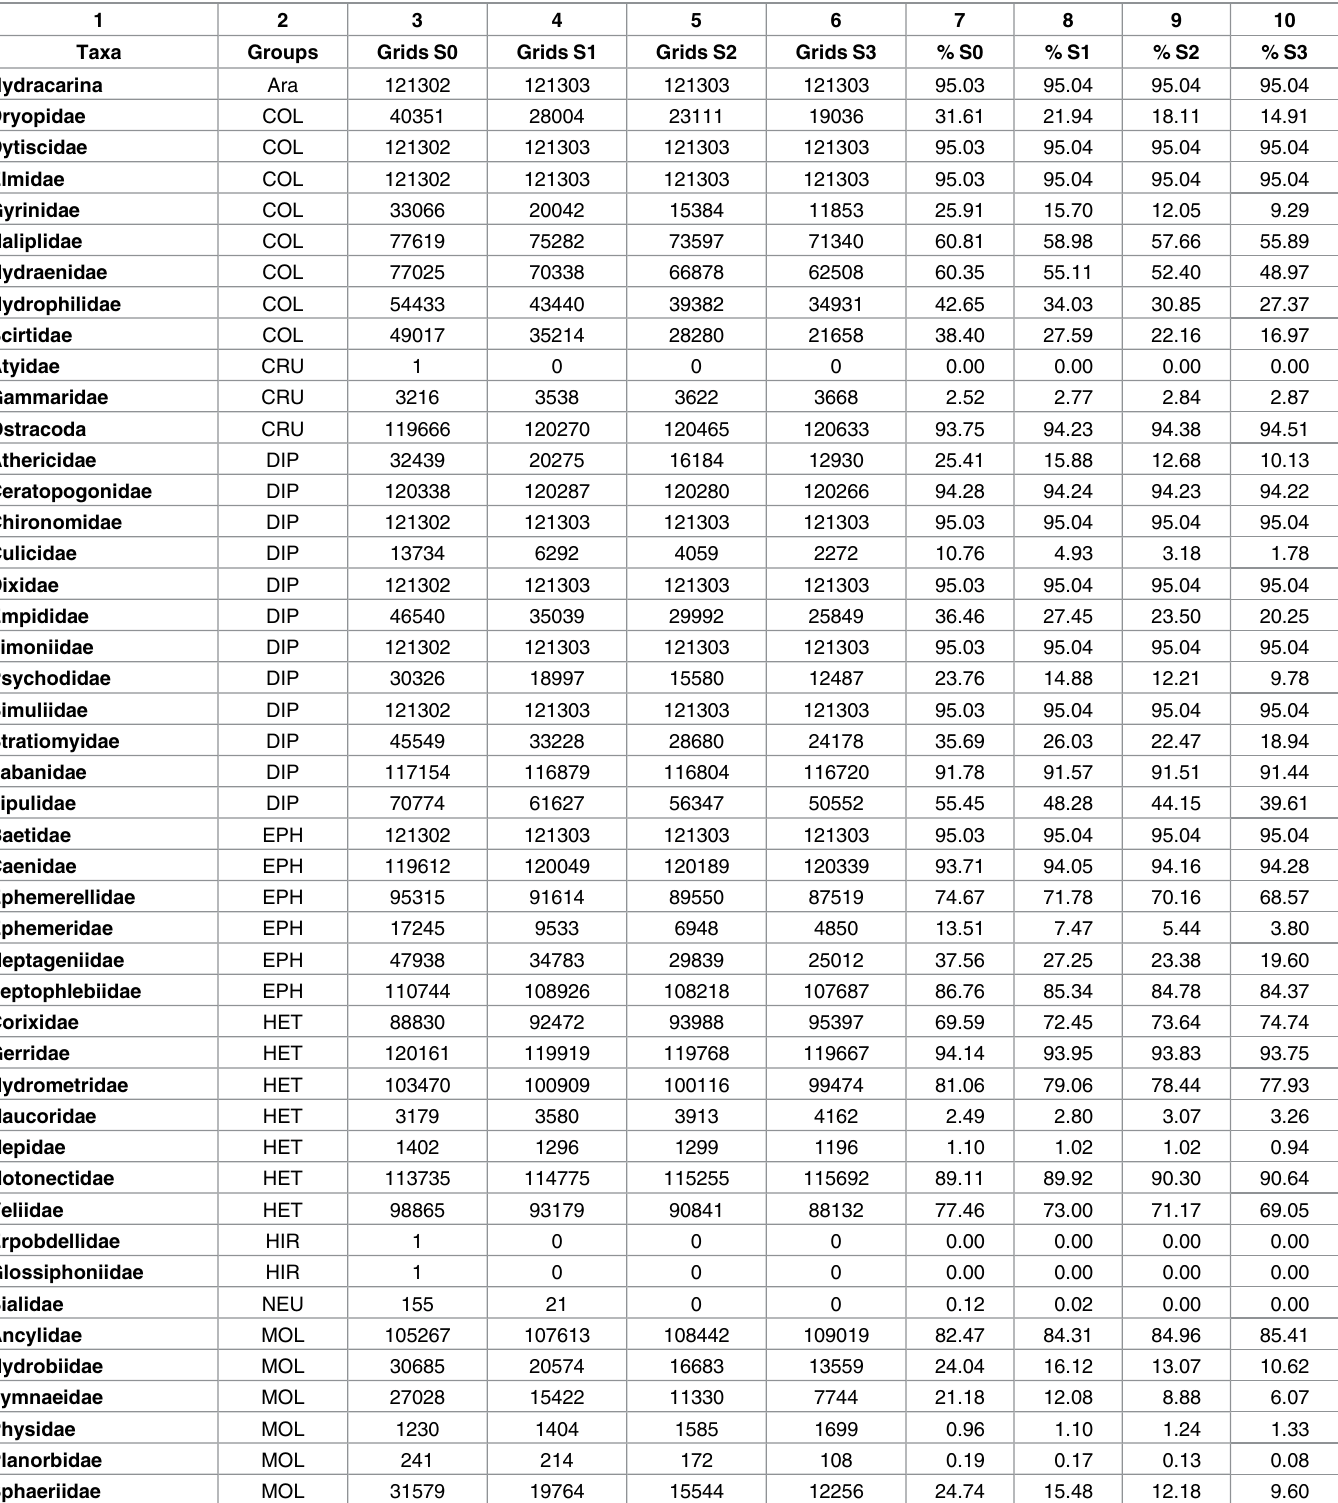
Table 2. List of macroinvertebratetaxa included in the study and their area of presence for each modelled